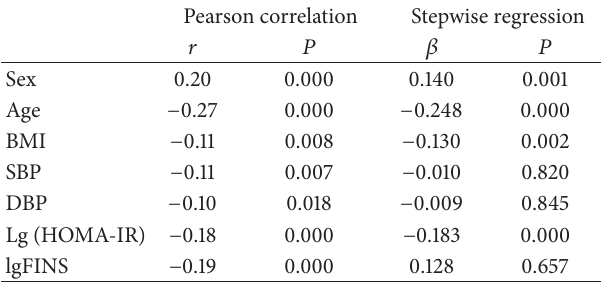
Table 2: The correlation and regression analyses of Lg (vitamin